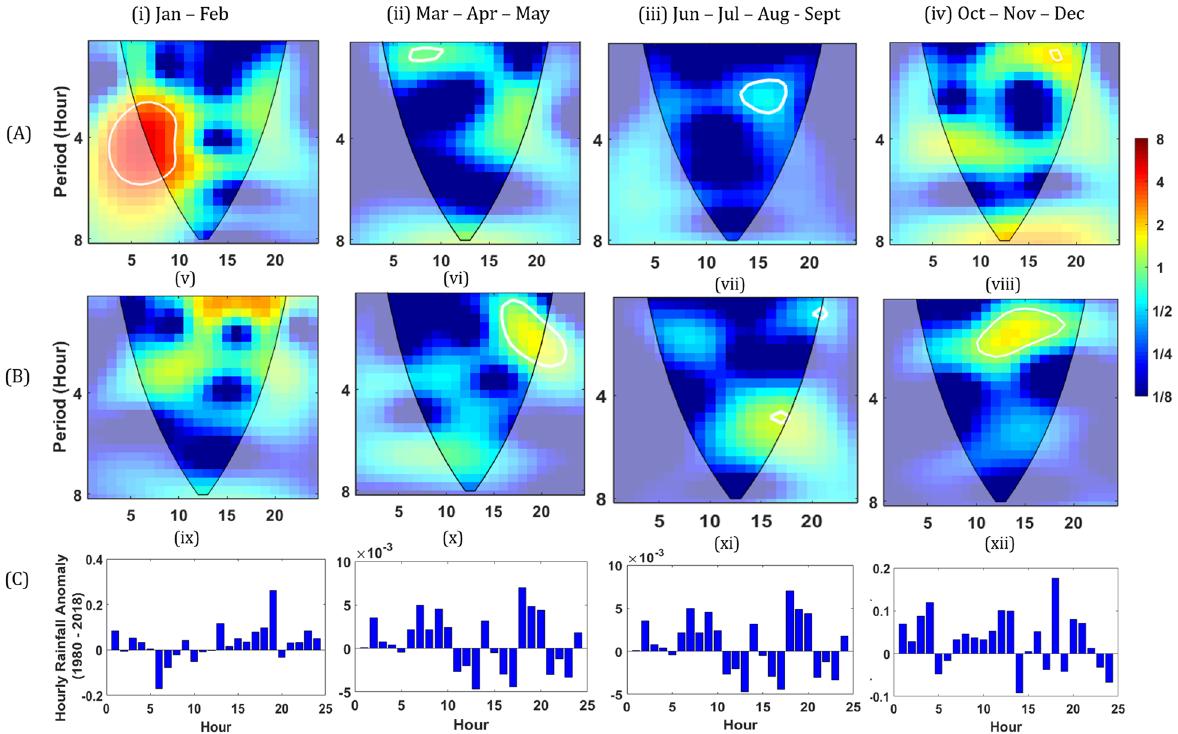
Fig. 5 A Wavelet transform of hourly rainfall during 1980–1999 time period for (i) Jan – Feb, (ii) Mar-Apr-May, (iii) Jun-Jul-Aug-Sept, and (iv) Oct-Nov-Dec; B is same as A but during 2000–2018 time period. The black line represents the cone-of-influence and white contours represent the 95% significance level; C Variation of hourly rainfall anomaly for 1980–2018 for (ix) Jan – Feb, (x) Mar-Apr-May, (xi) Jun-Jul-Aug-Sept, and (xii) Oct-Nov-Dec over